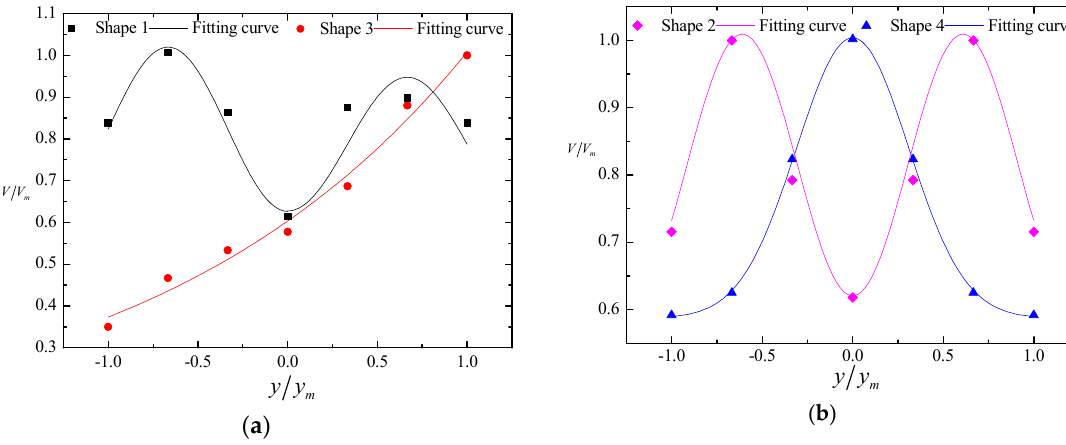
Figure 6. Nappe wind distribution in the lateral direction in the physical model test: ( a ) shape 1 and shape 3; ( b ) shape 2 and shape 4.